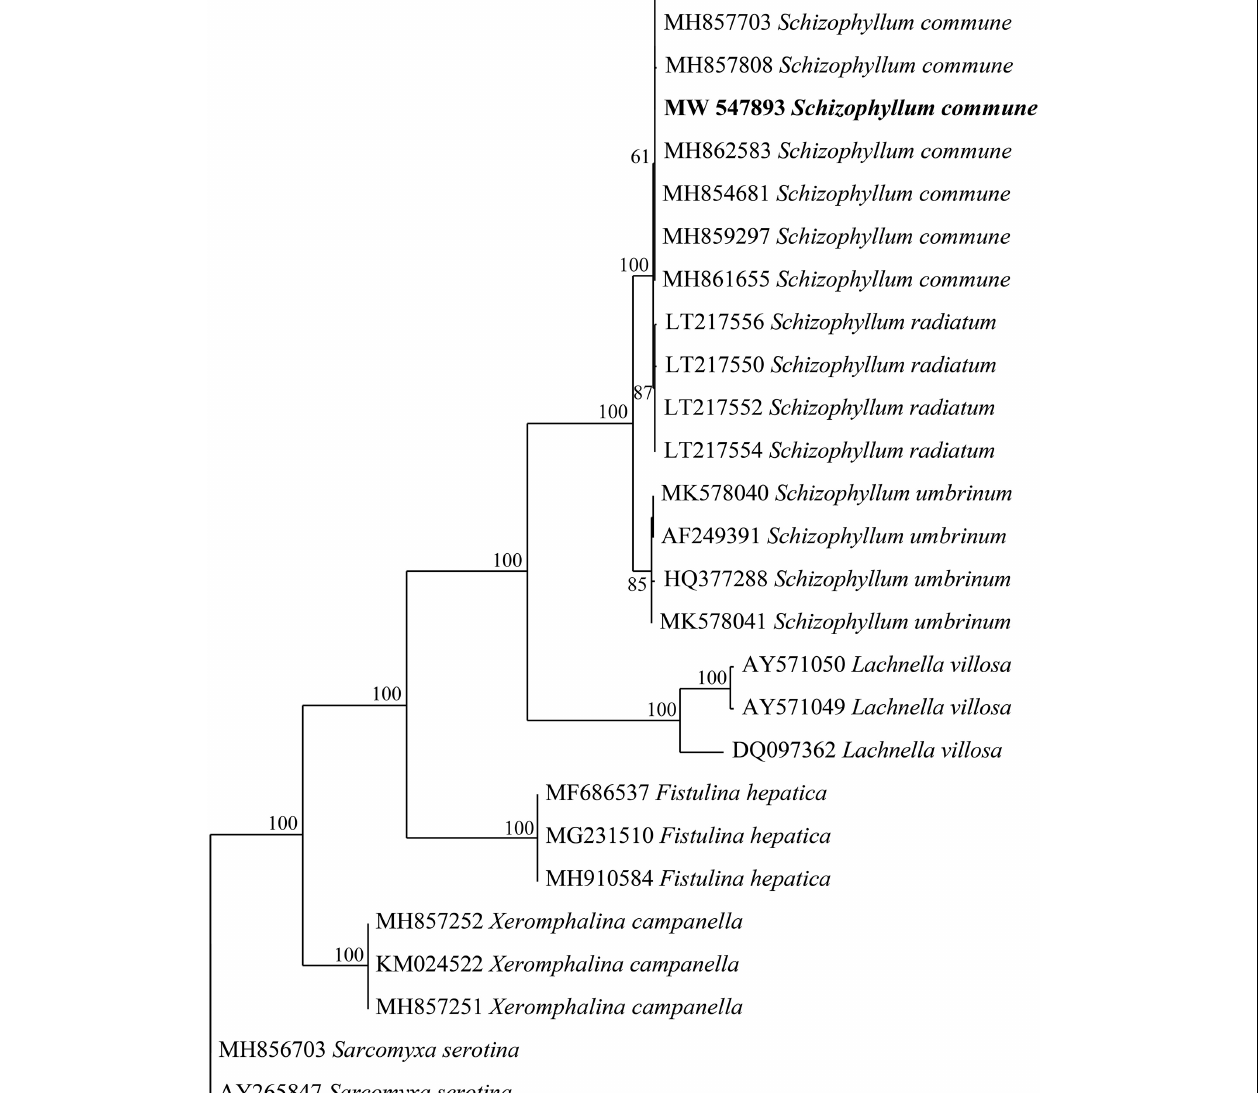
from a mixture of Han 849 and Han 881 were nearly 9. 90 −